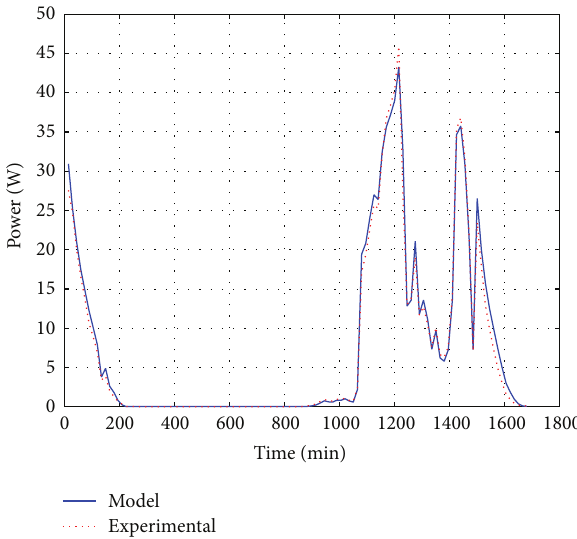
Figure 9: Comparison of the simulation results and thin-film panel